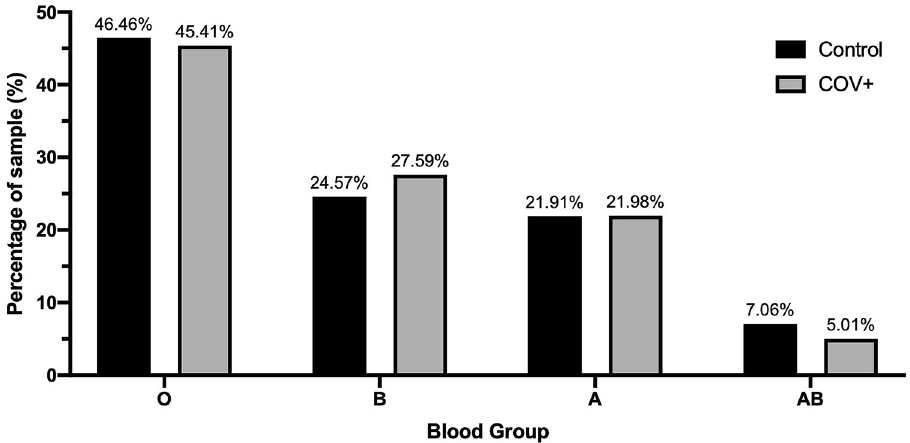
Figure 1. Blood group distributions in the non-COVID-19 (control) and COVID-19 positive (COV +) samples.